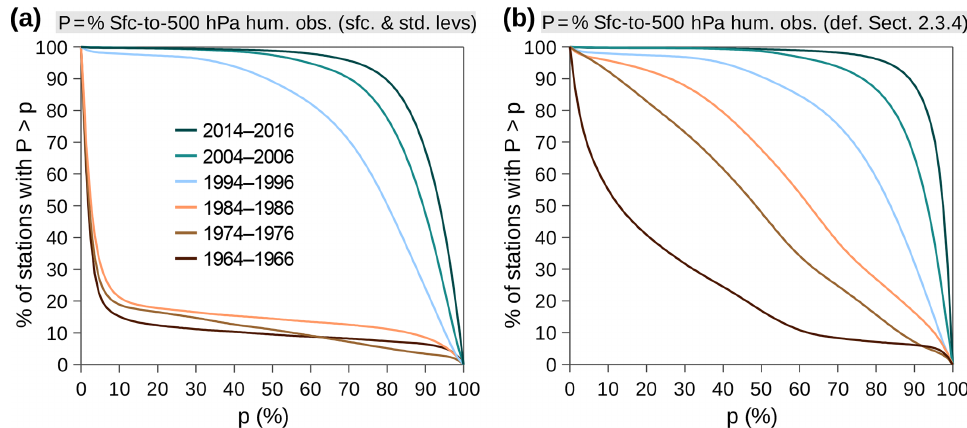
Figure 10. Percentage of stations, out of all IGRA-RS stations, with a percentage of Sfc-to-500hPa humidity soundings exceeding a given value (shown in abscissa), out of the humidity soundings in several trienniums with 10-year intervals (see inset of panel a ): (a) requiring humidity data at the surface level and all current standard levels above the surface up to 500hPa; (b) using the definition of “Sfc-to-500hPa humidity soundings” given in Sect.